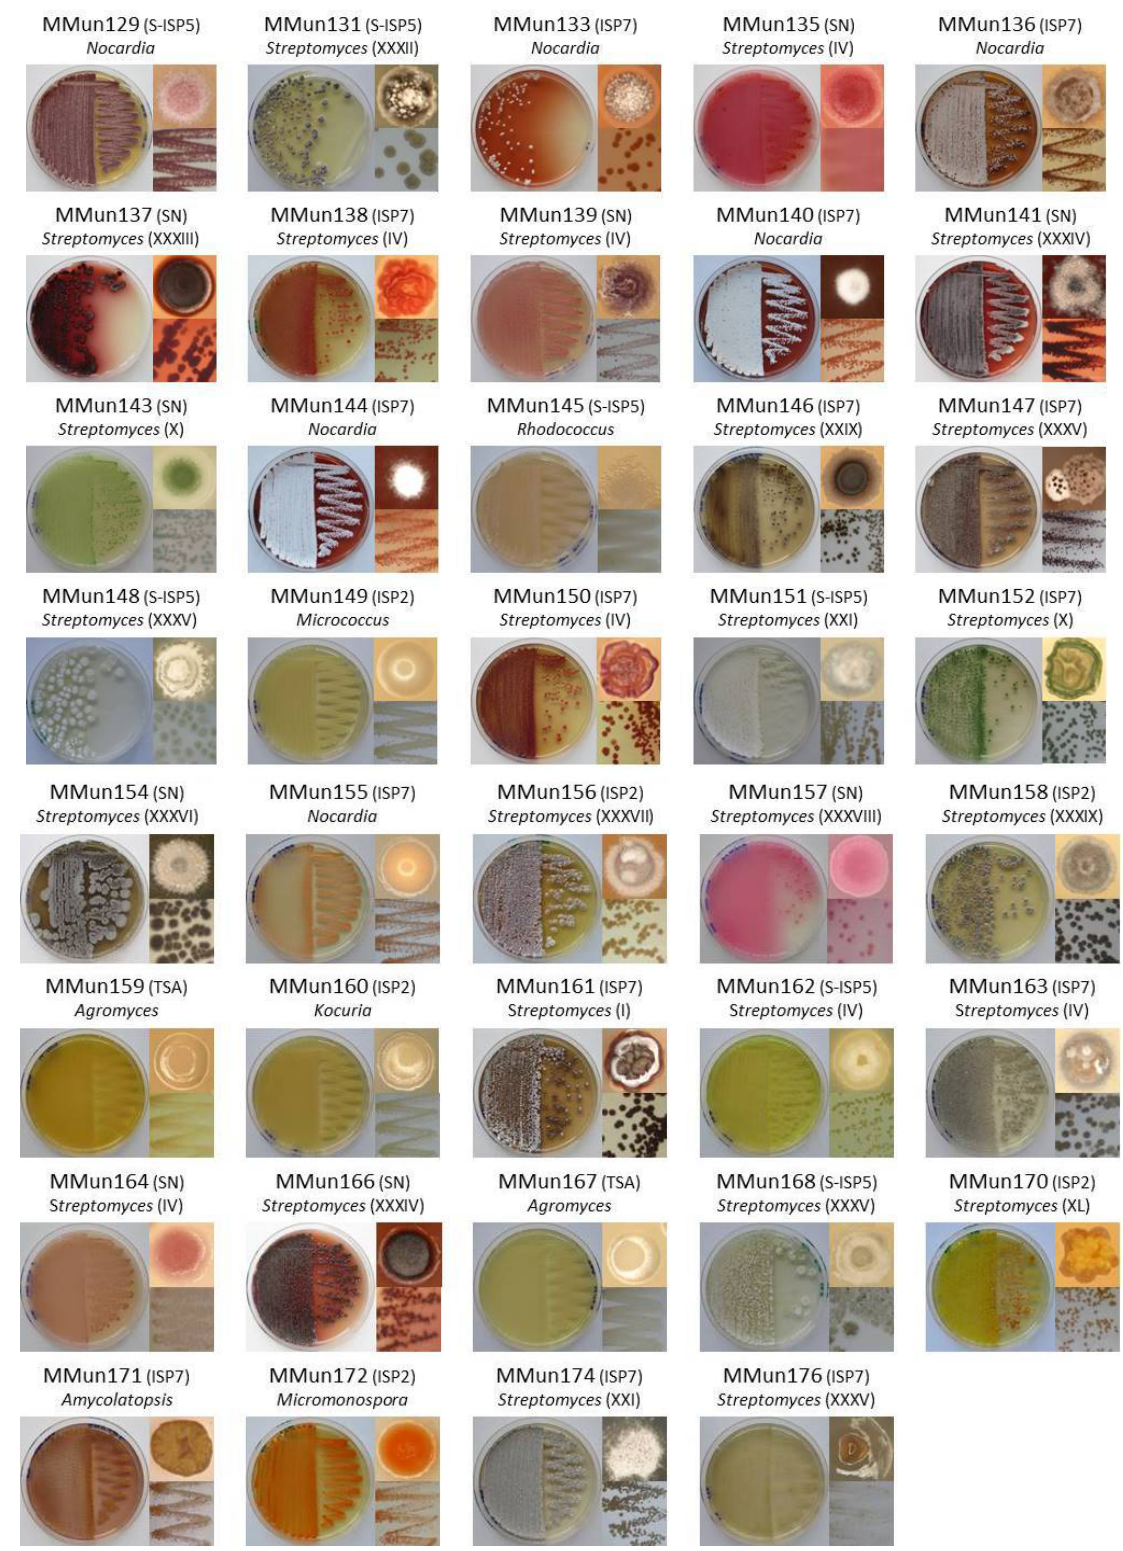
Figure 3. Phenotypes of actinobacterial strains isolated in this study. For each isolate, the front and back of the Petri dish-grown bacteria are presented together with the phenotype of a single colony. The phylotype number for Streptomyces isolates is indicated in parentheses.